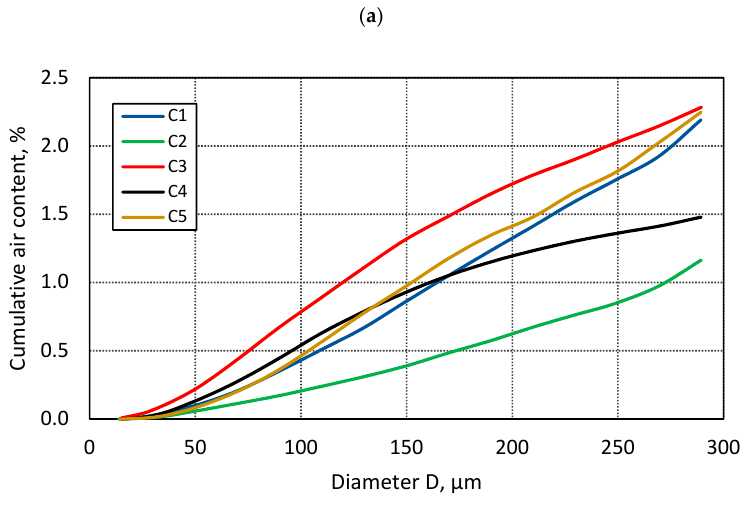
( a ) ( b ) Figure 7. A comparison of EN 480-11 data versus the 2D analysis results for L : a ) equivalent diameter based 2D analysis; b ) perimeter based 2D analysis. ( a ) ( b )